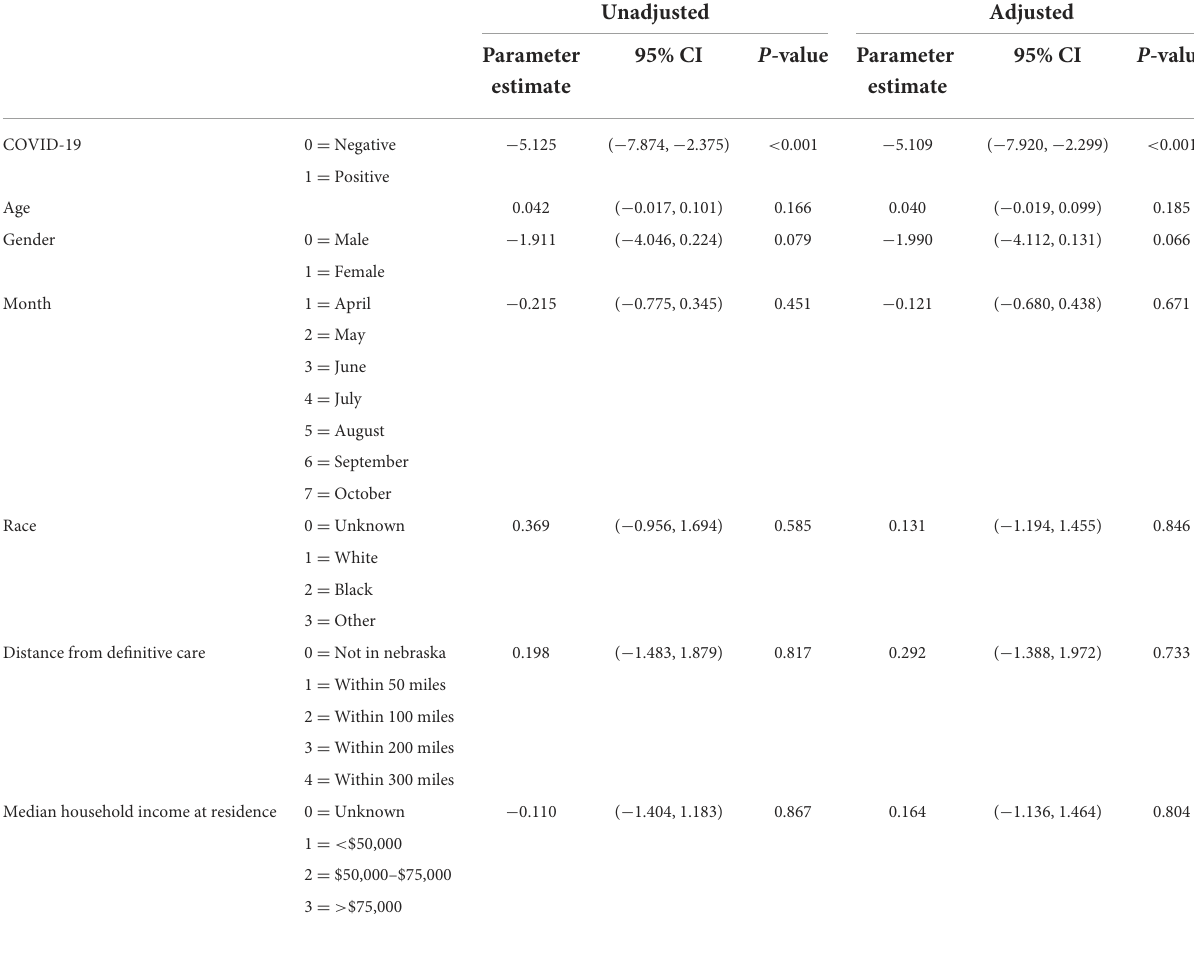
TABLE 3 Linear regression analysis for length of stay among patients at Nebraska Medicine between April and October 2020, Omaha,